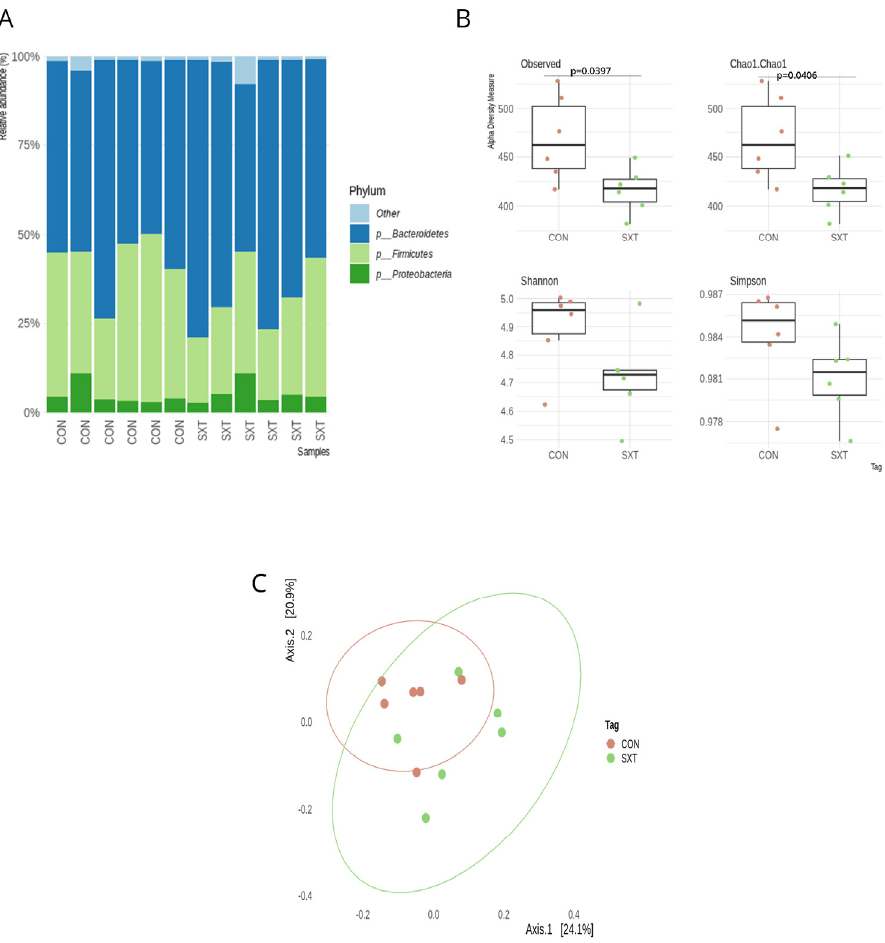
Figure 3. The gut microbiota composition of gut microbiota between of control (CON) and cotrimoxazole (SXT) C57BL/6 mice. ( A ) Relative abundance at the phylum level for groups of CON (n = 6) and SXT (n = 6) C57BL/6 mice; ( B ) richness (Observed and Chao1) and diversity (Shannon and Simpson) indexes for groups of CON (n = 6) and SXT (n = 6) C57BL/6 mice; ( C ) PCoA of Bray-Curtis distances among groups of CON (n = 6) and SXT (n = 6) C57BL/6 mice. Each point corresponds to a community from a single mouse. Colors indicate group identity. Ellipses show the 95% confidence intervals. Intra-group differences were evaluated using ADONIS test ( p < 0.05).